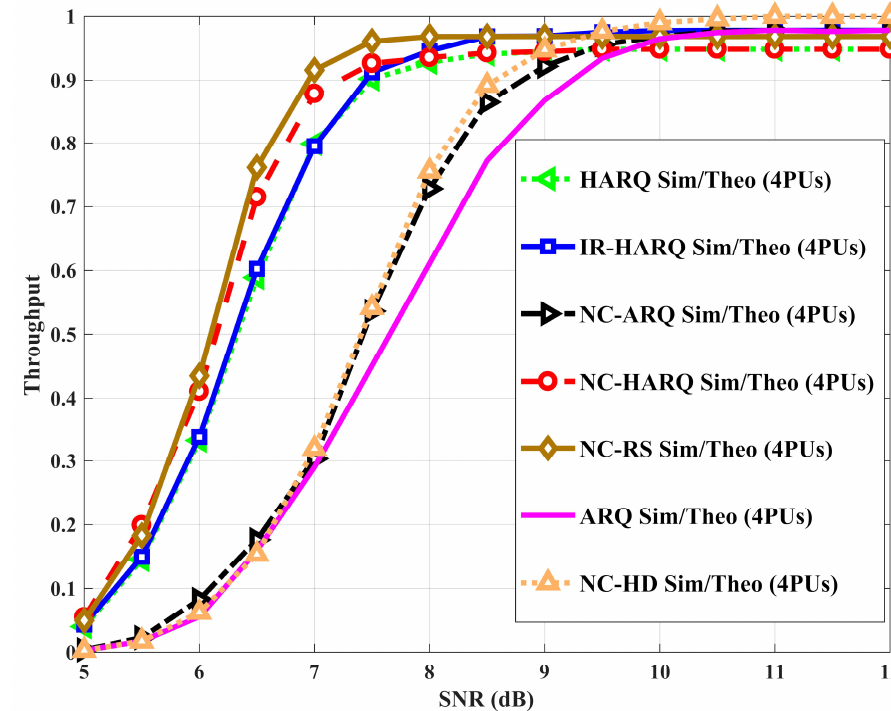
Figure 2. Broadcasting throughput comparison.